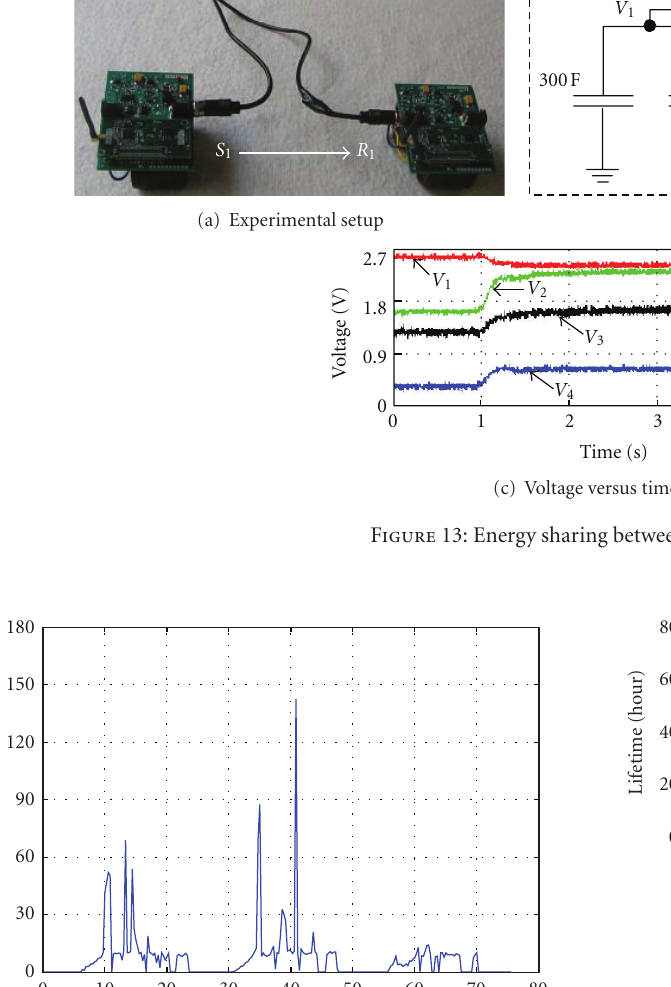
Figure 15: Impact of energy sharing e ffi ciency.